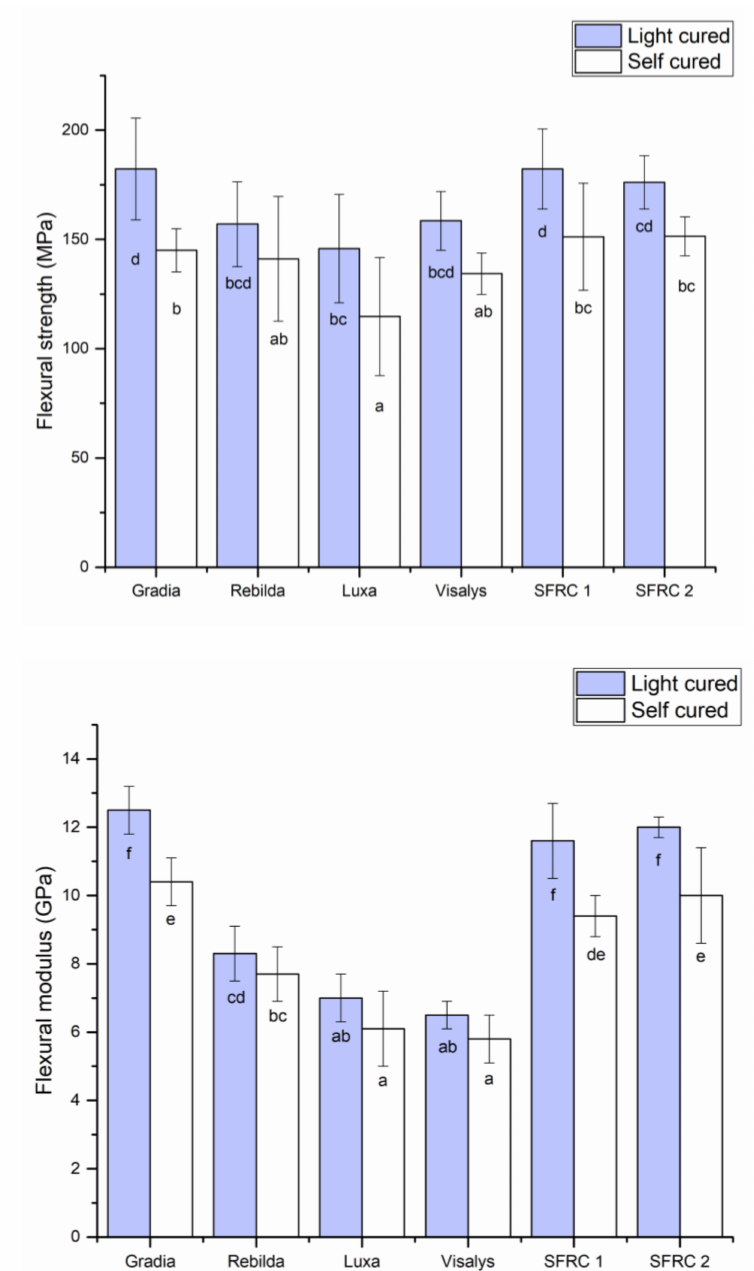
Figure 1. Bar graphs showing mean flexural strength (MPa) and flexural modulus (GPa) with standard deviations (SD) of tested DC resin composites. Groups denoted with the same letters are not statistically different ( p <